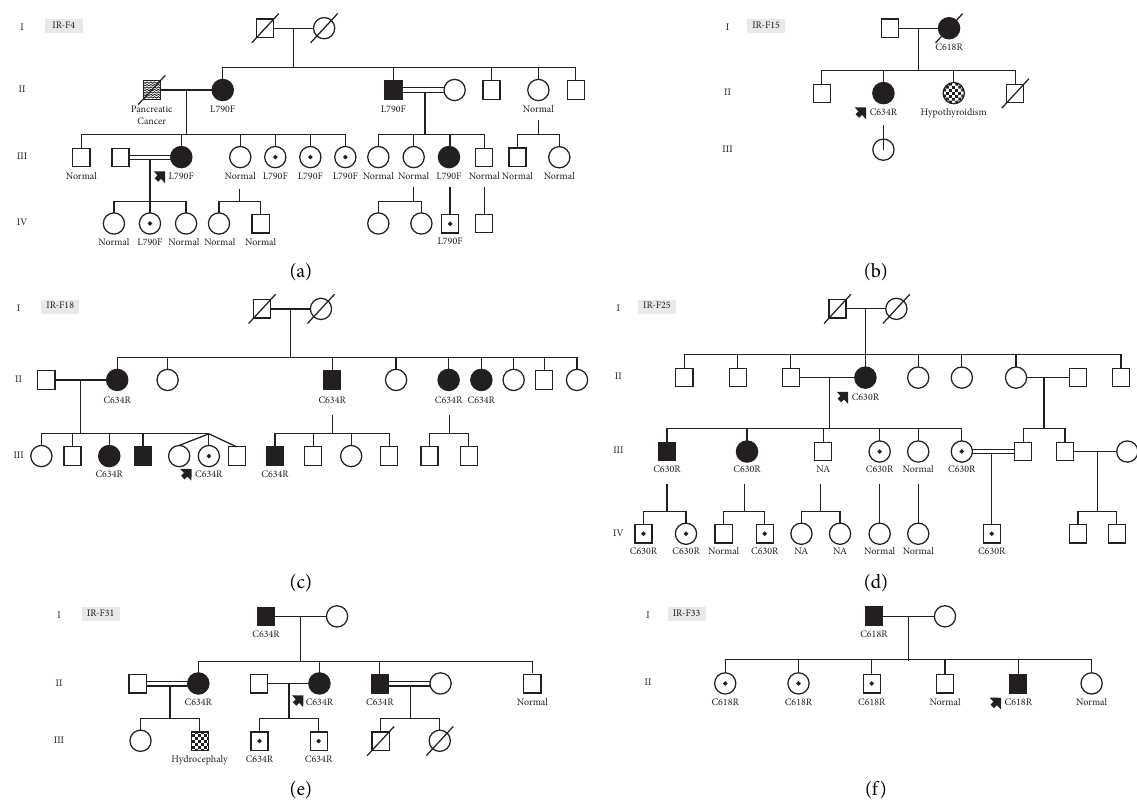
Figure 1: Pedigrees of families with MEN2: (a) IR-F4, (b) IR-F15, (c) IR-F18, (d) IR-F25, (e) IR-F31, and (f) IR-F33. Blackened symbols: affected individuals; dotted symbols: asymptomatic carriers; other symbols: individuals with symptoms other than MEN2; and dashed symbols: